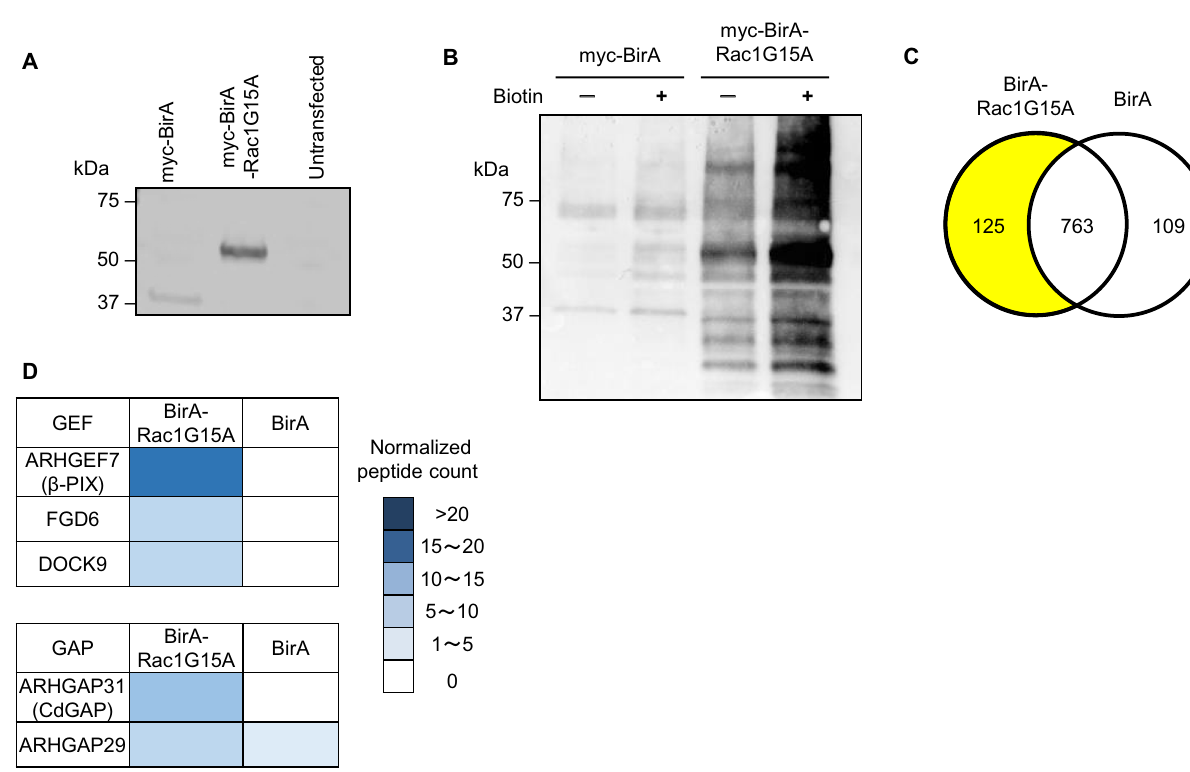
Figure 1. CdGAP and β-PIX interact with Rac1 in podocytes. ( A ) Doxycycline-inducible myc-BirA (control, 37 kDa) or myc-BirA-Rac1G15A (60 kDa) were stably expressed in cultured human podocytes. Both cell lines were treated with doxycycline for 16 h as described in Experimental Procedures. Representative immunoblot for myc is shown. ( B ) After 16 h incubation with biotin and doxycycline, presence of biotinylated proteins was verified by immunoblotting for streptavidin. ( C ) Venn diagram of proximity interactions identified in BirA- Rac1G15A expressing podocytes and controls expressing BirA alone. ( D ) Heatmap representing normalized peptide counts toward each bait of three GEFs and two GAPs, which are significantly enriched in BirA- Rac1G15A expressing podocytes compared to